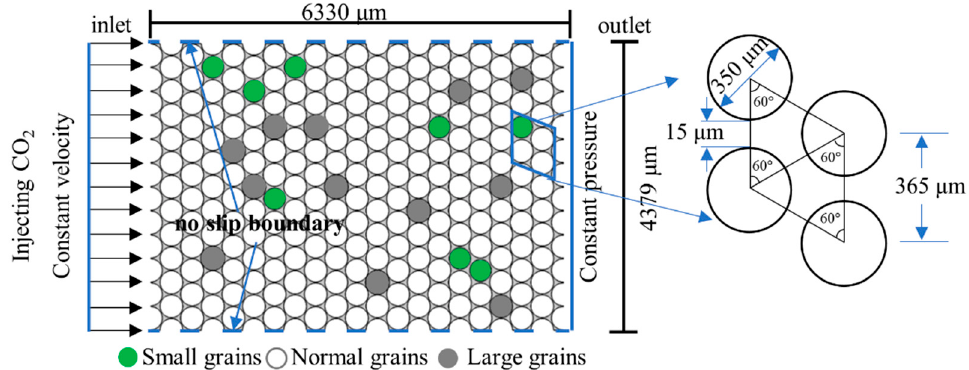
Figure 2. Schematic diagram of the model domain and initial and boundary conditions for numerical simulations of CO 2 /oil flooding in heterogeneous porous media.